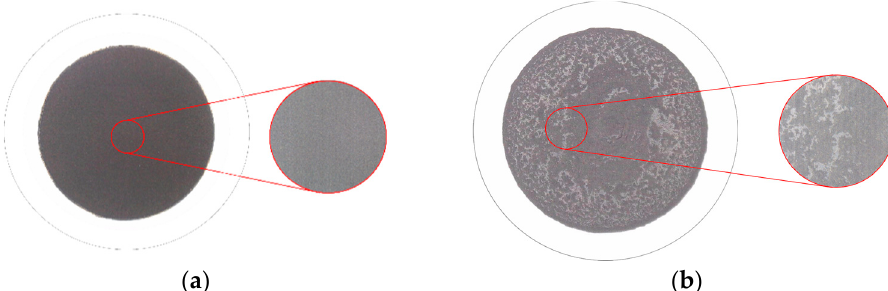
Figure 2. Optical micrographs of a catalytic film on the surface of the electrode fabricated by rotational ( a ) and stationary ( b ) drying.